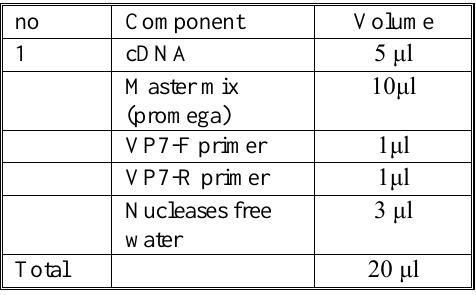
Table1.First round PCR reaction mixture.